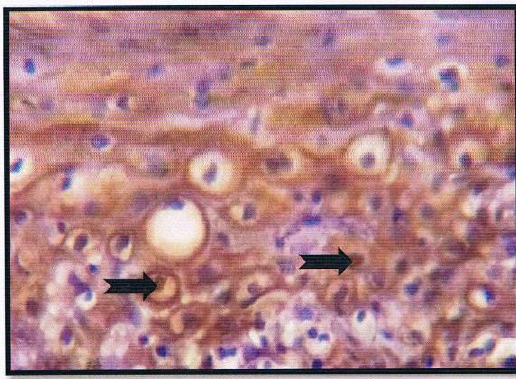
Figure 4: Positive nuclear and cytoplasmic expression of p21 in moderate dysplasia. (200X)